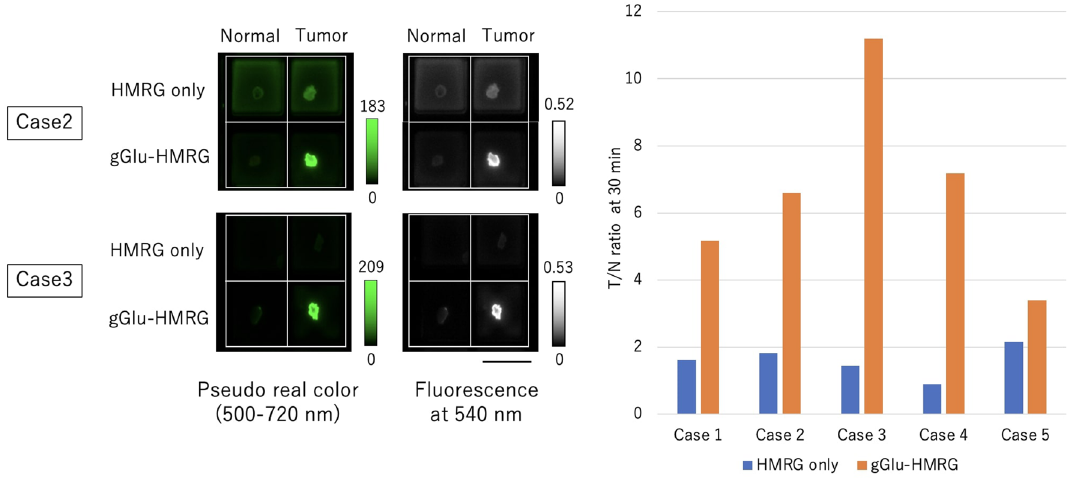
Figure 3. Fluorescence imaging with gGlu-HMRG or HMRG alone. Specimens were incubated with gGlu-HMRG (50 μM) or HMRG (1 μM) for 30 min and the tumor-to-normal (T/N) ratio, i.e., the ratio of fluorescence intensity of the tumor to that of normal tissue at 30 min, was calculated. Five cases were tested, and fluorescence imaging of two representative cases is shown. gGluHMRG showed a higher T/N ratio in cancer tissues, indicating that cancer tissues have higher GGT activity than normal tissues. Scale bar, 10